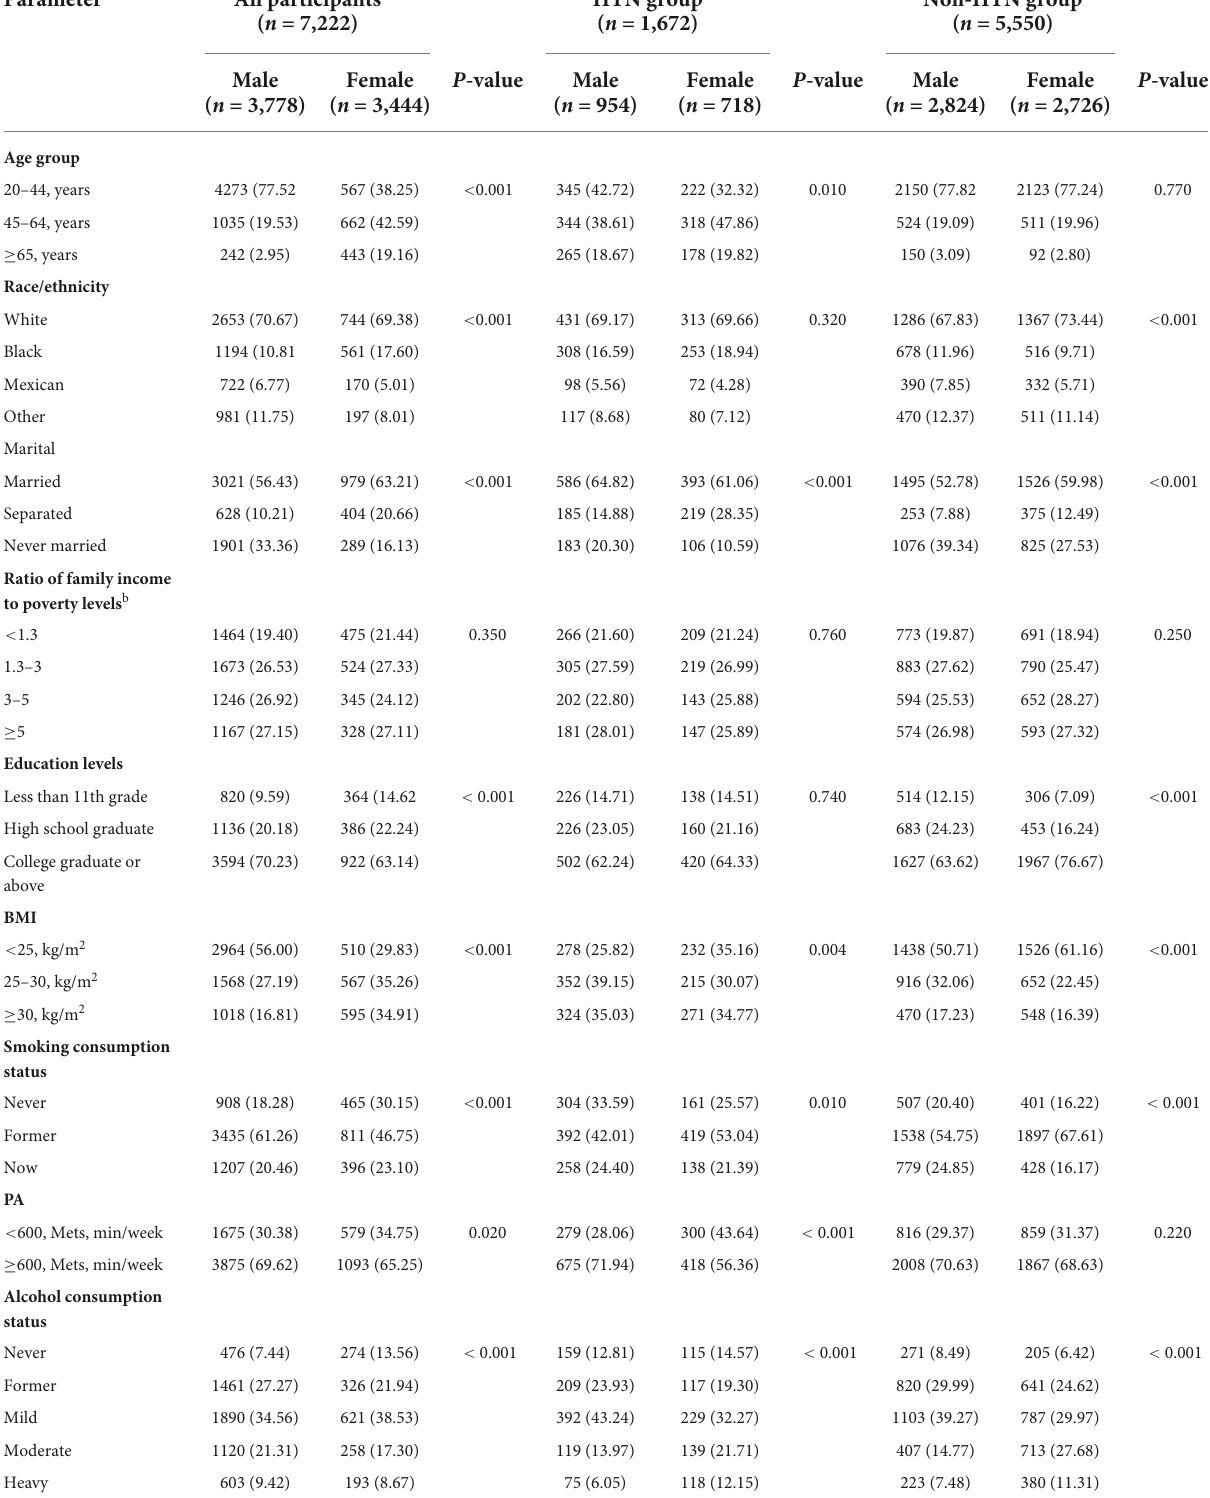
TABLE 2 Participant characteristics by hypertension status with sex differences: a cross-sectional study using NHANES data from 1999 to 2018.